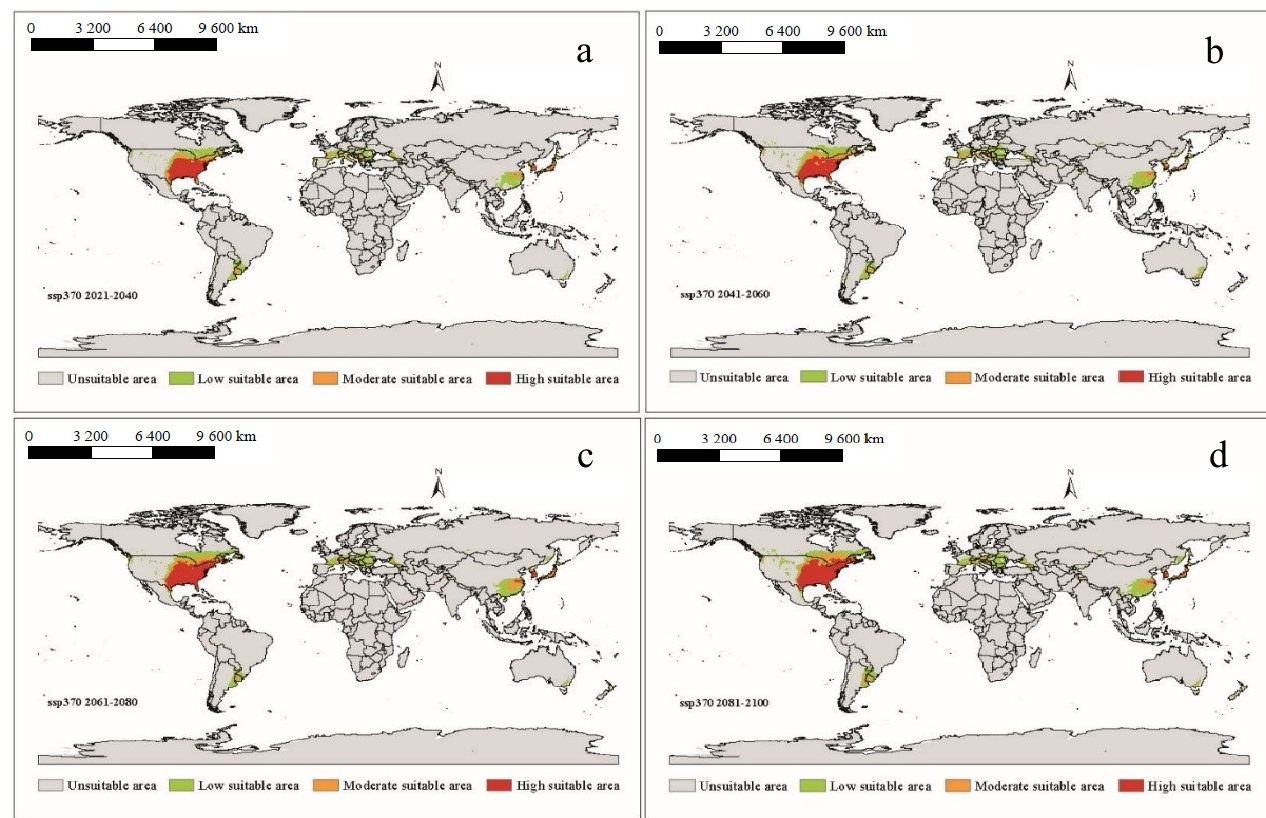
Figure 6. The potential distribution of suitable areas for A. americanum around the world under the climatic conditions of shared socio-economic pathway 1–2.6 (sustainability and radiative forcing of 2.6 W/m 2 to 2100) during different periods of the 21st century: ( a ) 2021–2040, ( b ) 2041–2060, ( c ) 2061–2080 and ( d )